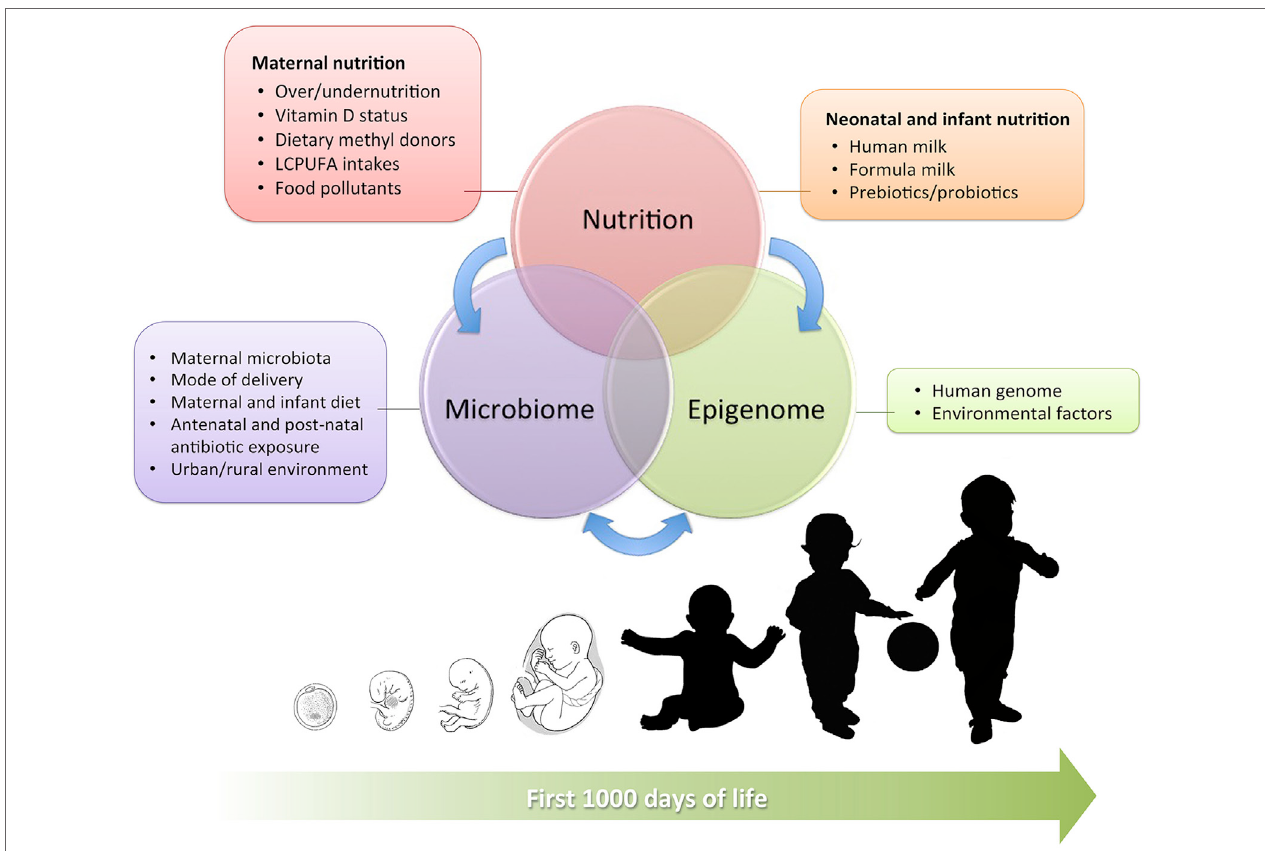
FiGURe 1 | Interrelation between maternal and neonatal nutrition, gut microbiota, and epigenetics during the first 1,000 days of life. The main influencing factors are detailed in the boxes.